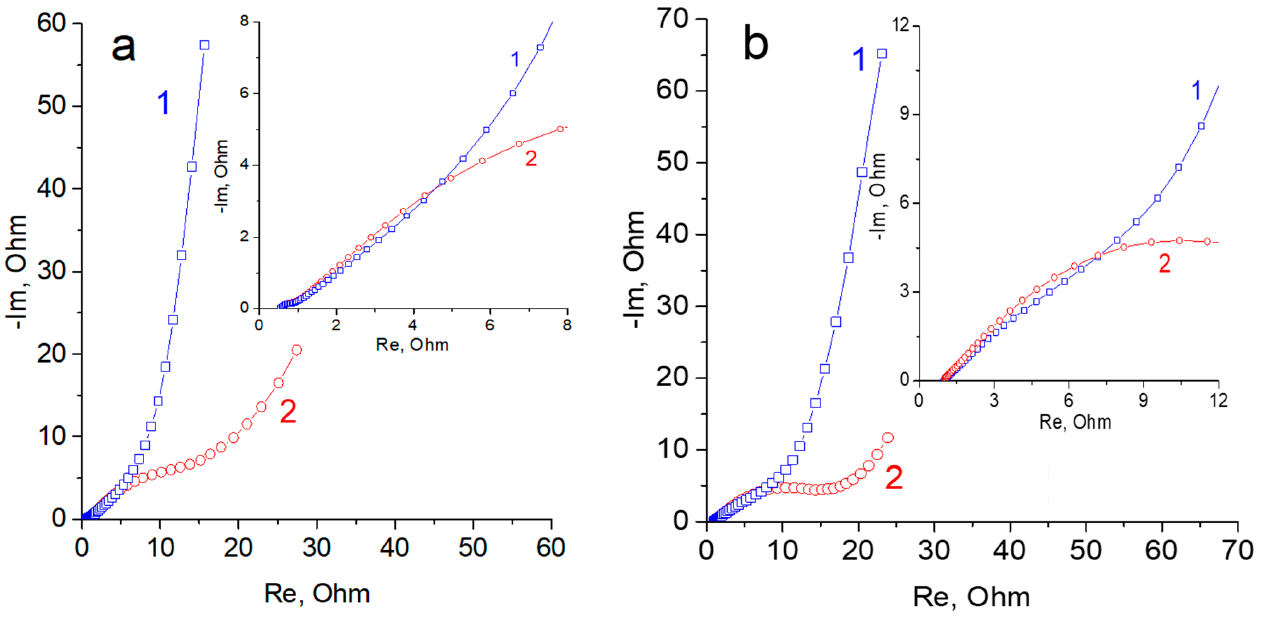
Figure 11. ( a ) Nyquist diagram for the rGO/TiO 2 15% composite for different states of the electrode: 1—EDL region ( − 150 mV); 2—region of charged pseudocapacitance of TiO 2 ( − 880 mV). The insertion illustrates the region of mid frequencies in large scale. The frequency diapason was 100 kHz to 10 MHz. ( b ) Nyquist diagram for the rGO/TiO 2 30% composite for different states of the electrode: 1—EDL region ( − 200 mV); 2—region of charged pseudocapacitance of TiO 2 ( − 900 mV). The insertion illustrates the region of mid frequencies in large scale. The frequency diapason was 100 kHz to 10 MHz.